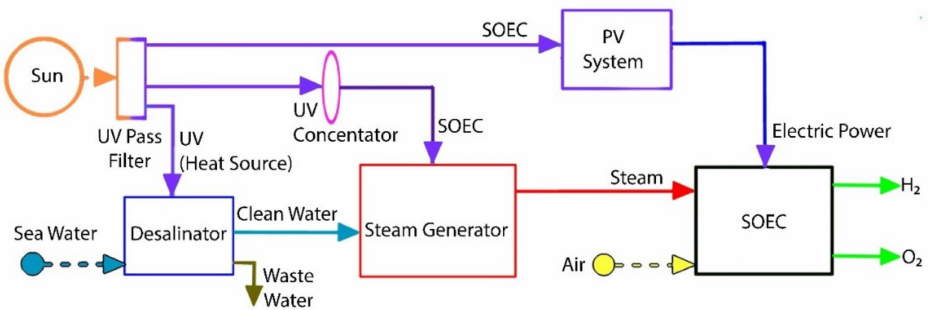
Figure 1. Block diagram of the proposed experimental setup with three subparts: desalinator, CPV system, and team generator. Each of these is supplied by concentrated UVA and UVB obtained from an optically active Fresnel lens array. SOEC is fed by superheated steam at 650 ◦ C.